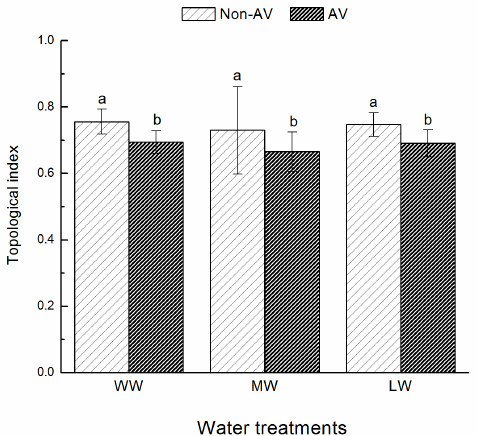
Figure 4. Root topological index of O. hosiei seedlings inoculated with A. vagum , a dark septate endophyte, and grown under di ff erent drought stress conditions. Treatments: Non-AV, non- A. vagum ; AV, A. vagum ; WW, well watered; MW, moderate water; LW, low water. Thick bars represent the means and thin bars represent standard errors for n = 5. Di ff erent letters indicate group with significant di ff erences for p < 0.05.